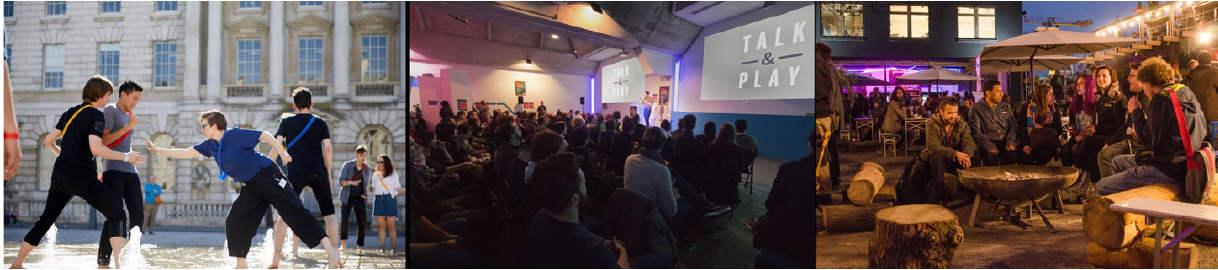
Figure 3. Social play events create unique experiences around playing and making practices as evident with through: (a) the physical play of Carpe Diem (Lun, 2017) at Now Play This―Copyright by Ben Peter Catchpole (2017, reprinted with permis- sion); (b) the consideration of speaker and topic diversity at Talk & Play―Copyright by Julian Dasgupta (2017, reprinted with permission); (c) and the informal social spaces provided by A MAZE. / Berlin―Copyright by Jens Keiner (2017, reprinted with